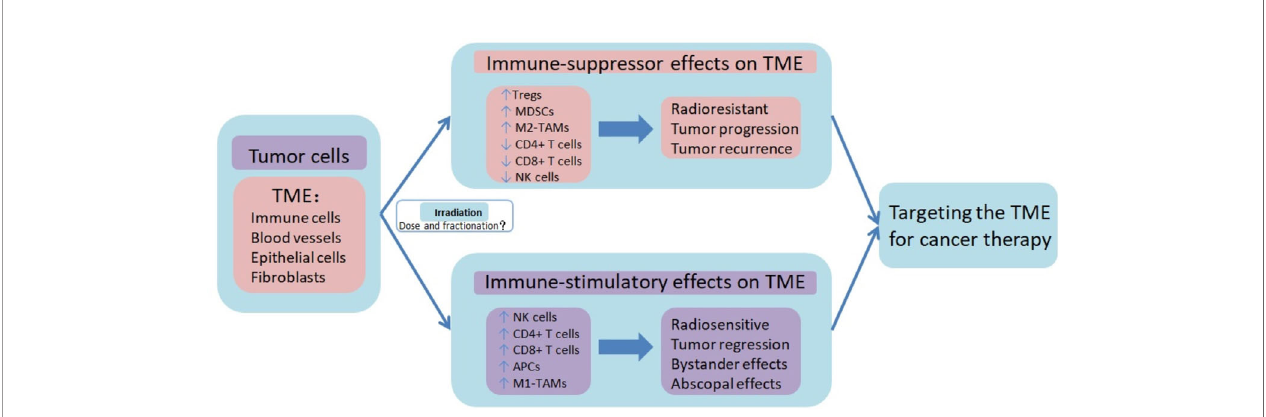
FIGURE 1 | Immune-suppressor effects and immune-stimulatory effects of radiotherapy on tumor microenvironment. Radiotherapy, especially hypofractionated irradiation, contributes to the induction of anti-tumor immune responses, which promote tumor control. Besides the immune-suppressor effects, radiotherapy also induces immunosuppression of TME, resulting in tumor progression and recurrence. The high in fi ltration of T cell lymphocytes in TME, known as immune hot or in fl amed phenotype, is characterized by high number of effector cells (NK cells, CD8+ T cells, and Th1 cells) and functional antigen-presenting cells (APCs), and TAMs with the M1 phenotype. On the contrary, the lack of T cell lymphocytes in fi ltration in TME, known as immune cold or nonin fl amed phenotype, is characterized by high numbers of Treg cells and MDSCs, lack of effector cells, and enrichment of immunosuppressive cytokines. However, it is not fully understood what dose and fractional radiotherapy induces the immune activated TME, and what dose and fractional radiotherapy causes the immunosuppressive TME. Combination therapy targeting TME may help to improve the therapeutic bene fi t of radiotherapy. TME tumor microenvironment, Tregs regulatory T lymphocytes, MDSCs myeloid-derived suppressor cells, M2-TAMs tumor-associated M2 macrophages, NK cells natural killer cells, APCs antigen-presenting cells, M1-TAMs tumor-associated M1